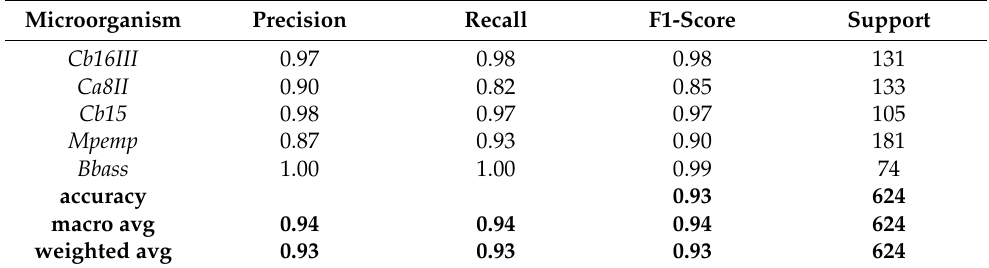
Table 3. Precision, recall, F1 score and support with model 2 for fungal spores. Microorganism